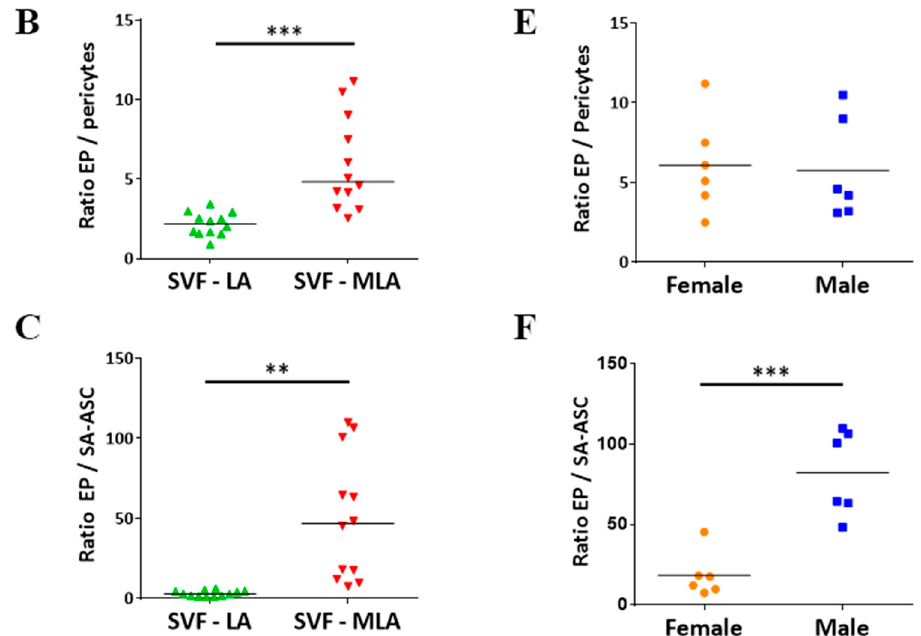
Figure 6. Comparative analysis of four cell subpopulations in SVF cells obtained from (SVF-LA or its SVF-MLA counterpart. Graphs A – C show a di ff erence in the ratios of the three progenitor subpopulations between SVF-LA and SVF-MLA. Di ff erences in the ratios of the three progenitor subpopulations in the SVF-MLA samples between female and male patients are shown in graphs D – F . p -values: (**) p < 0.01; (***) p < 0.001; n = 12.